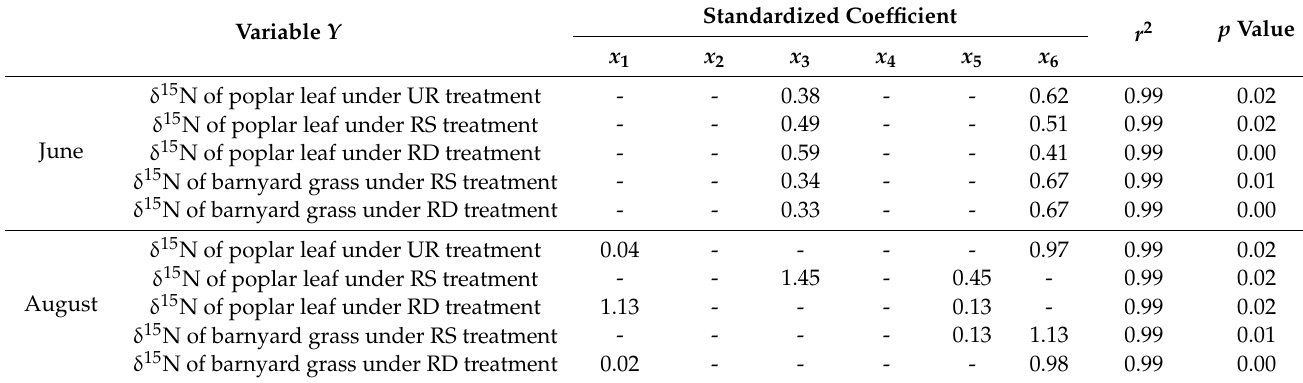
Table 2. Summary of stepwise regressions between δ 15 N values in plants with δ 15 N values of inorganic N. UR, RS and RD refer to the treatments of understory vegetation removal, the retention of a single main understory plant species, and the retention of naturally diverse understory vegetation, respectively. x 1 , x 2 and x 3 refer to the δ 15 N values of NH 4+ -N in the 0–5, 5–10, and 10–20 cm soil layers, and x 4 , x 5 and x 6 refer to the δ 15 N values of NO 3 − -N in the 0–5, 5–10, and 10–20 cm soil layers, respectively. The symbol “-” means that the independent variable was not incorporated into the regression model.